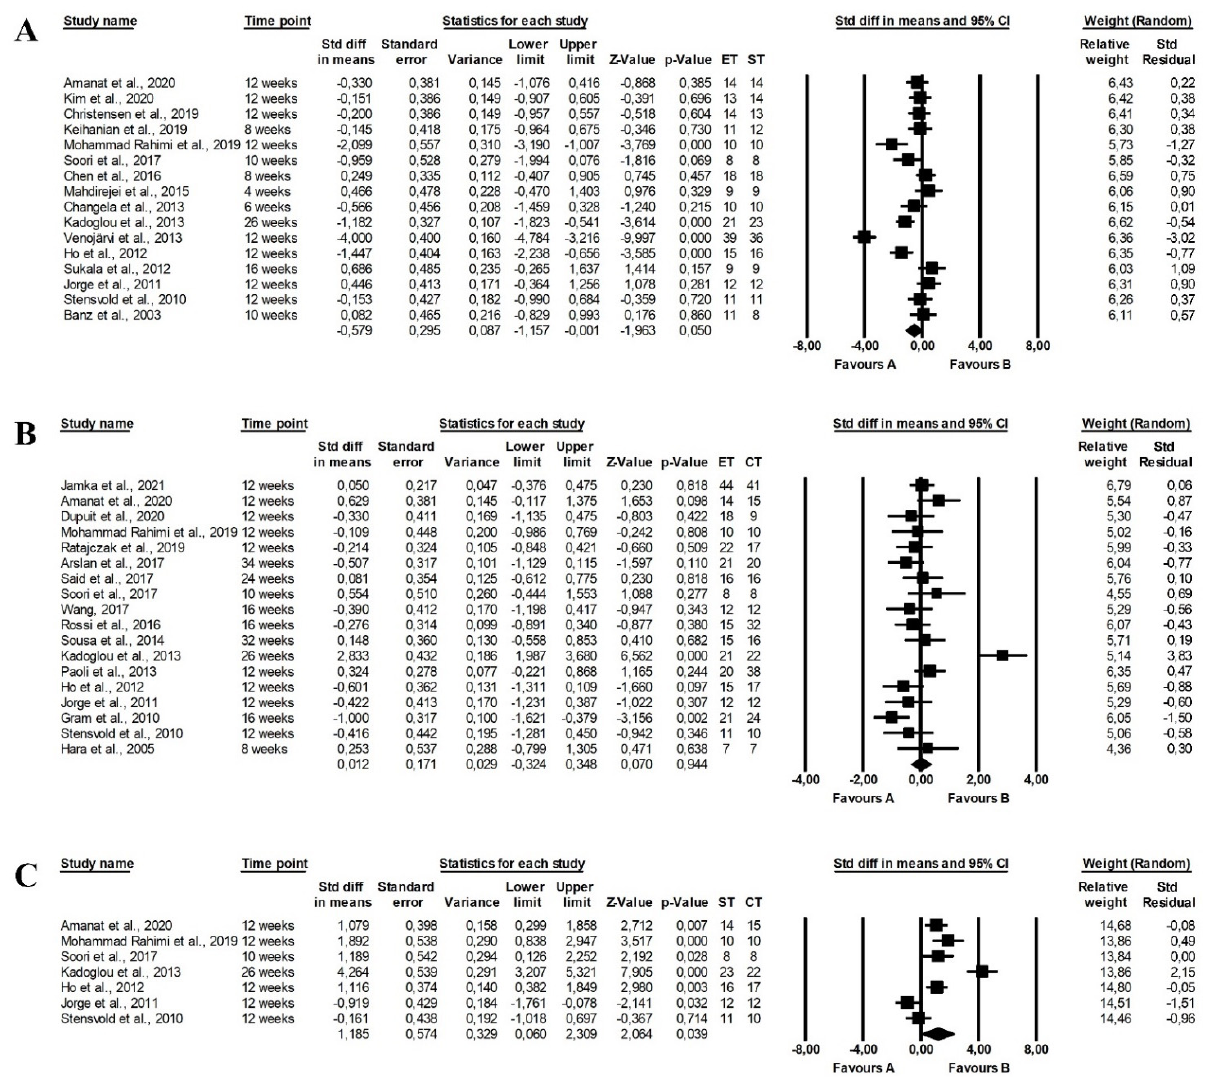
Figure 9. Forest plots of the effect of training programmes on total cholesterol levels: ( A ) endurance Forest plots of the effect of training programmes on total cholesterol (favours A) vs. levels: